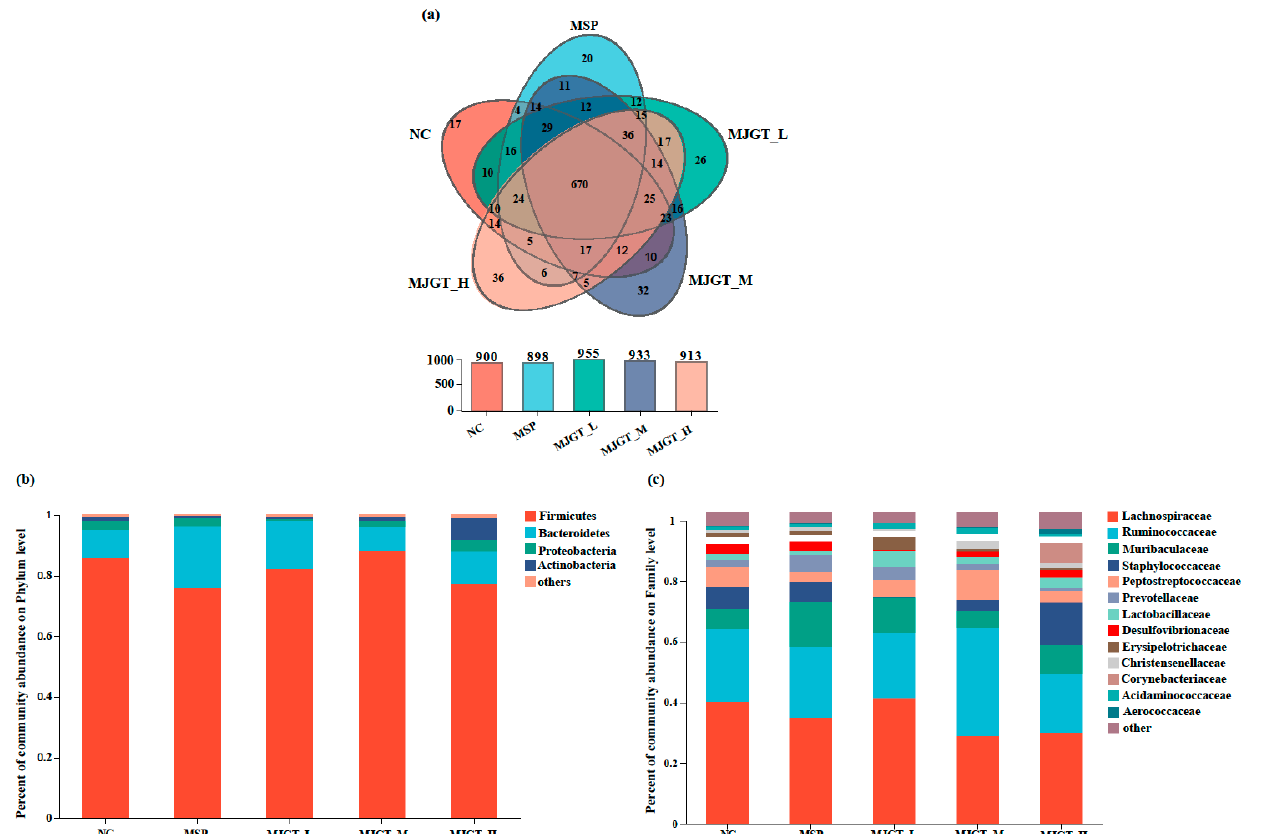
Figure 6. The analysis of the variations of gut microbiota treated by different concentrations MJGT hydro extract. The numbers and the differences of the OTUs among treatments are shown in panel ( a ), and the variations of microbiota composition are also displayed at the phylum ( b ) and family ( c ) level, respectively ( n = 4 for each group).